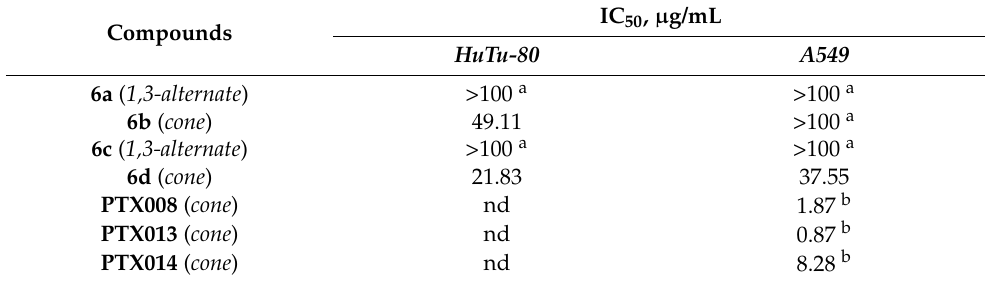
Figure 3. Cytotoxicity of compounds 6a – d on cell line HuTu-80 . Table 2. IC 50 values of the